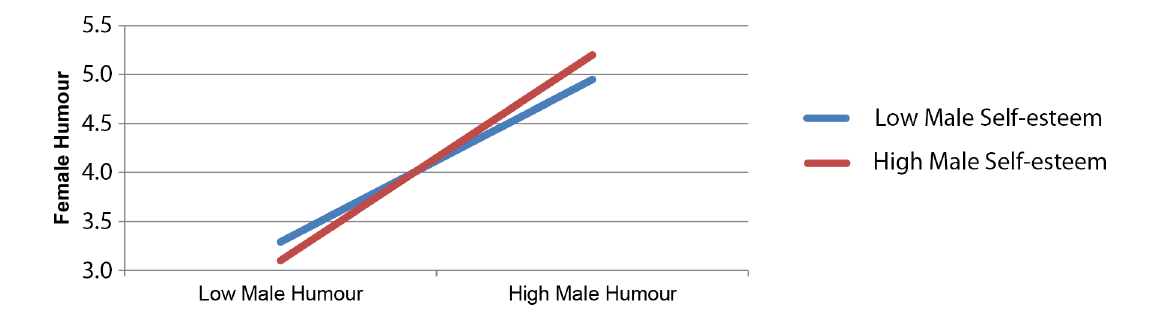
Figure 1. Moderation effects of male self-esteem in the association between male humour (predictor) and female humour (criterion).